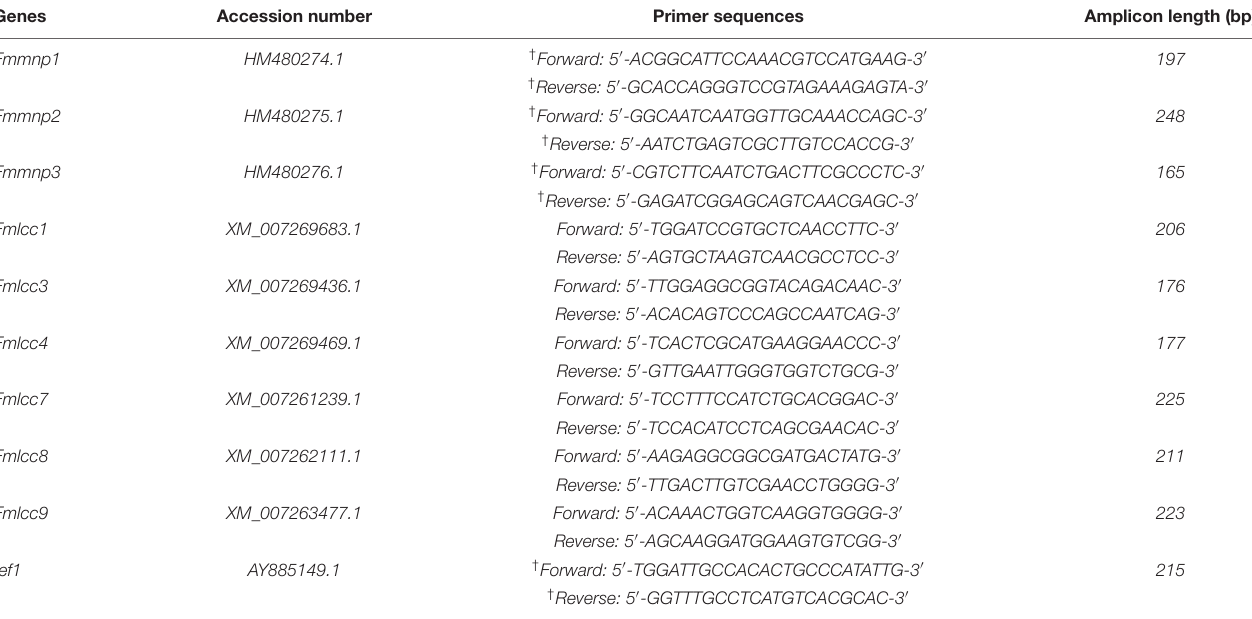
TABLE 2 | Gene accession numbers and sequences of primer pairs used for qRT-PCR. Genes Primer